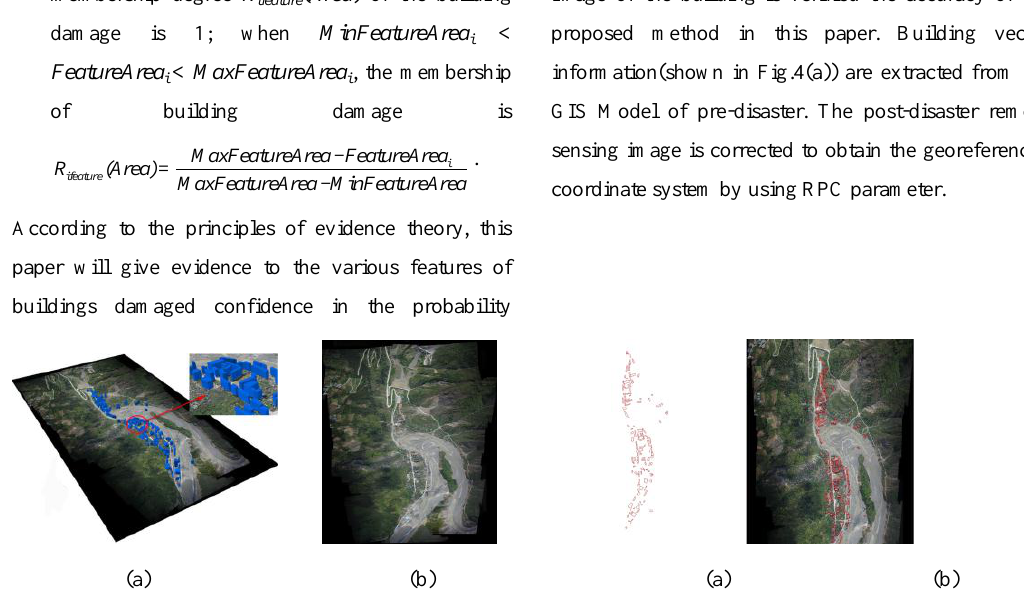
Fig.3 Beichuan data.(a)3D GIS model (b)Remote Sensing Image; Fig.4 (a) Building vector (b)The overlaying result of vector overlapping with the